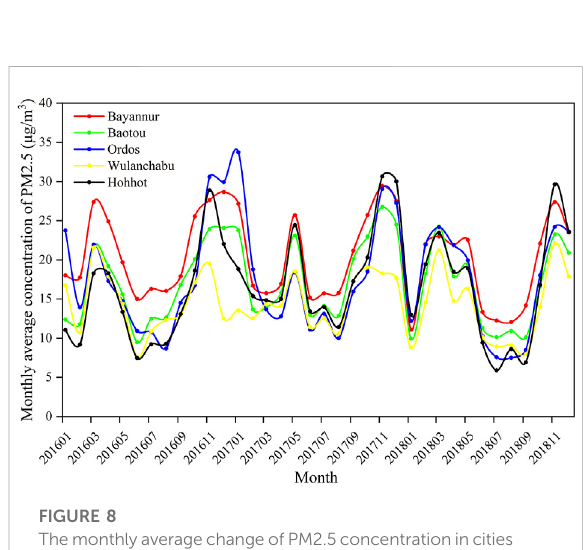
FIGURE 8 ThemonthlyaveragechangeofPM2.5concentrationincities from 2016 to